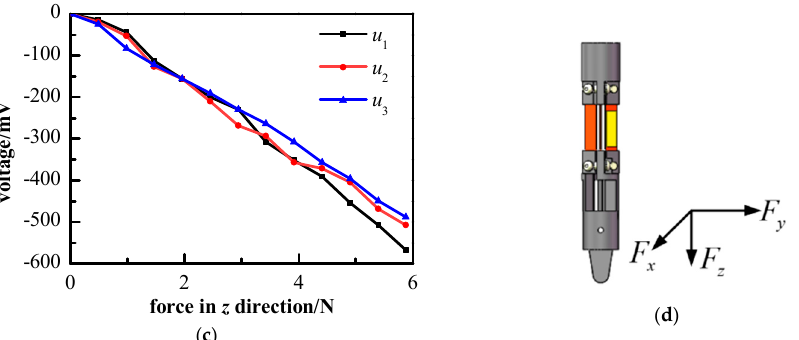
Figure 5. Calibration result of the force detection device: ( a ) calibration result of x -axis, ( b ) calibra- tion result of y -axis, ( c ) calibration result of z -axis, ( d ) schematic diagram of the direction of the loading force.